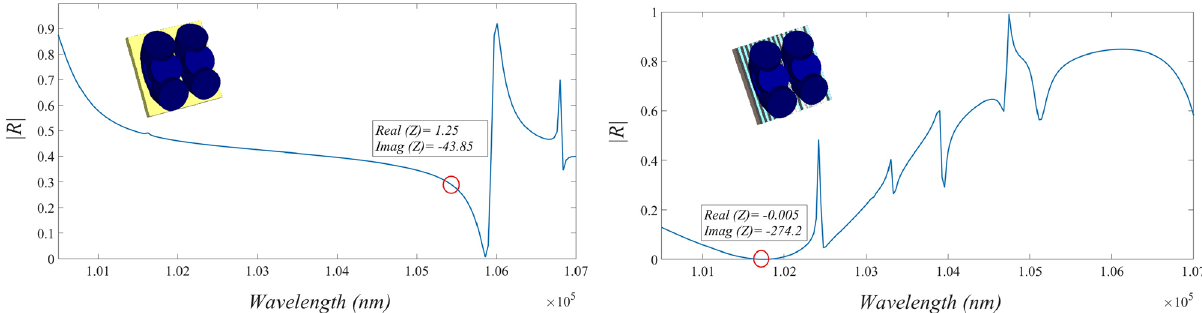
Figure 9. A unit cell reflectivity properties with applying graphene strip lines and without utilizing